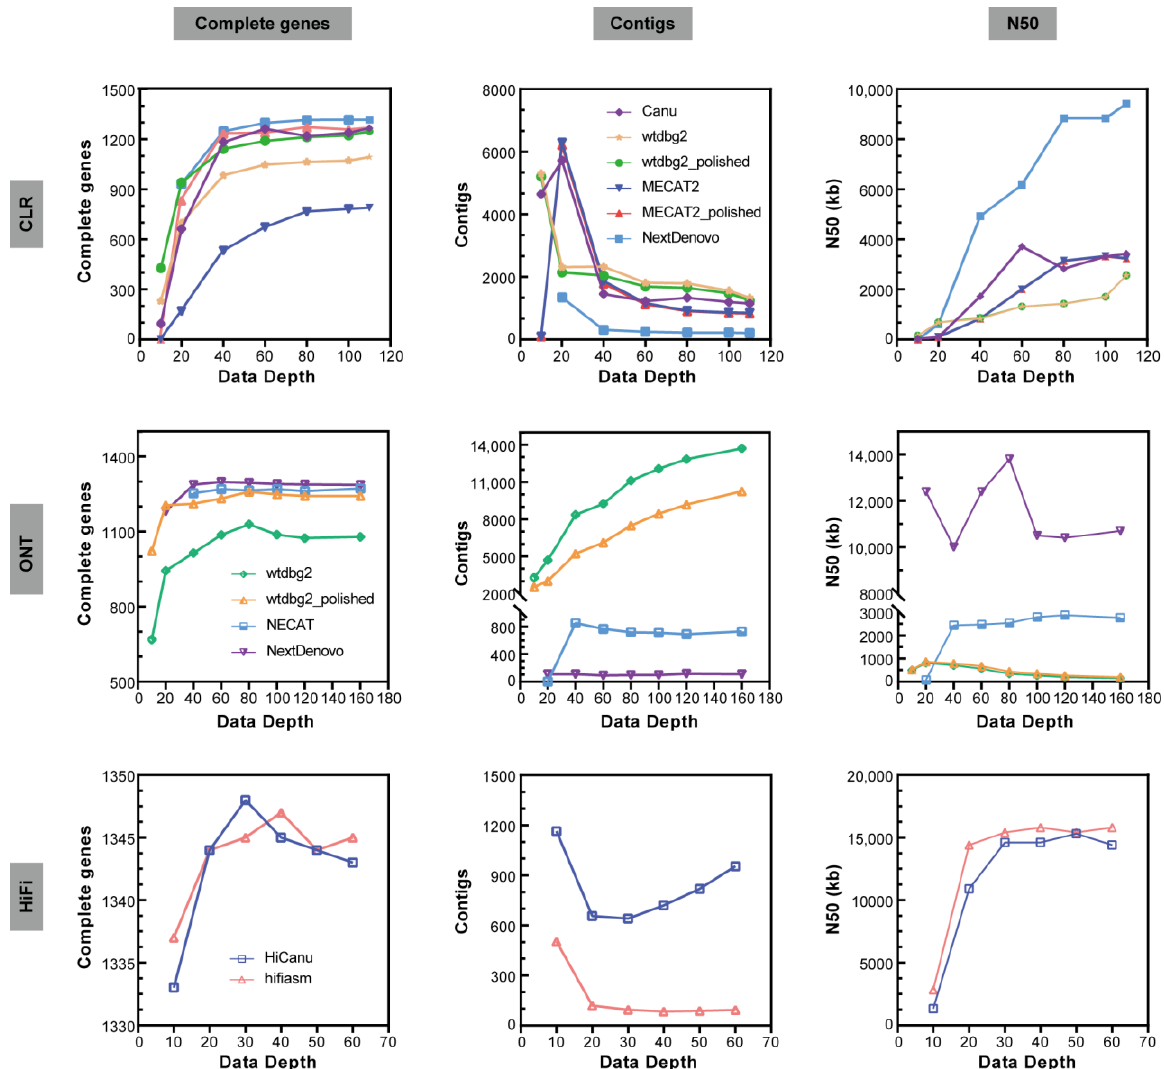
Figure 3. Main metrics of assemblies on CLR, ONT, HIFI subsets with different data depths. Complete gene number from BUSCO (Complete genes), contig number (Contigs), and N50 of contigs (N50).